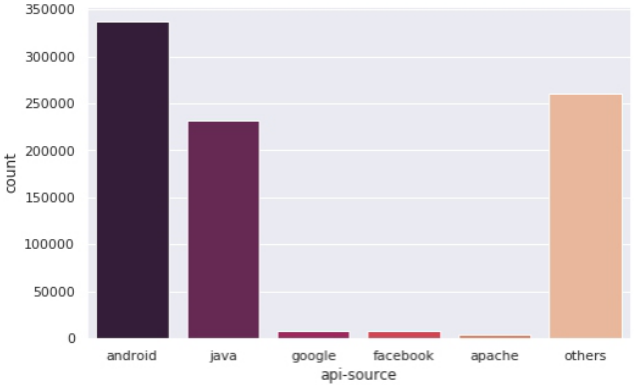
Figure 4. The distribution of the API